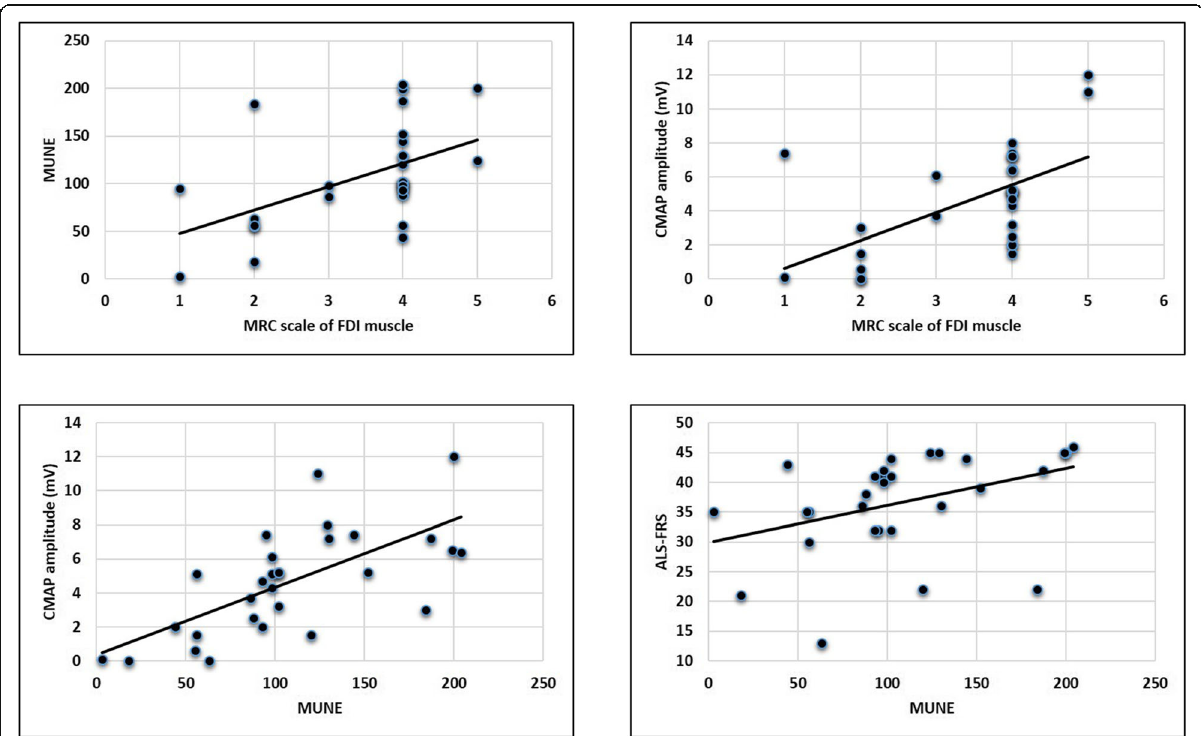
Fig. 1 Correlation between the MRC scale and the MUNE ( upper left ); MRC scale and the CMAP amplitude ( top right ); MUNE and CMAP amplitude ( lower left ); MUNE and the ALS-FRS ( bottom right